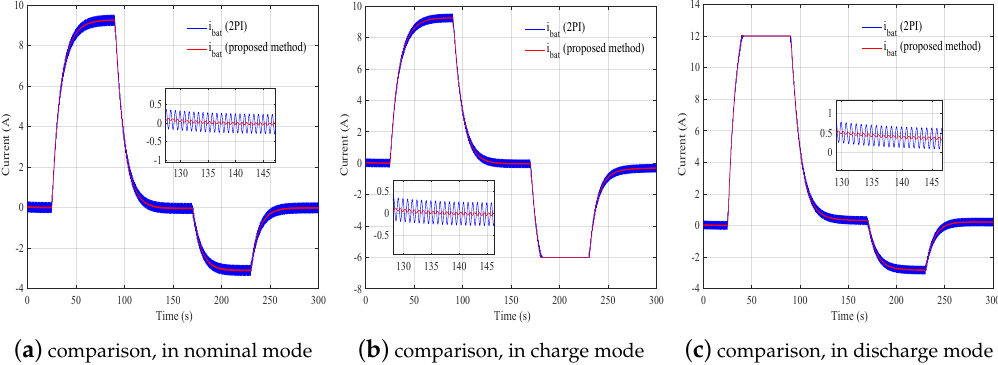
Figure 12. Comparison result of the proposed method with two PI